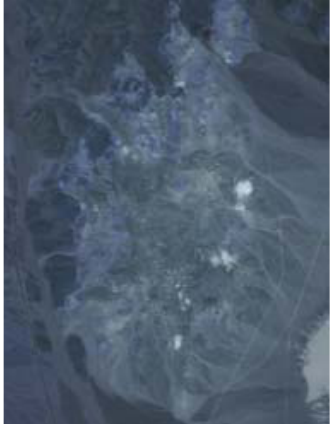
Figure 20. False-color image of the AVIRIS Cuprite